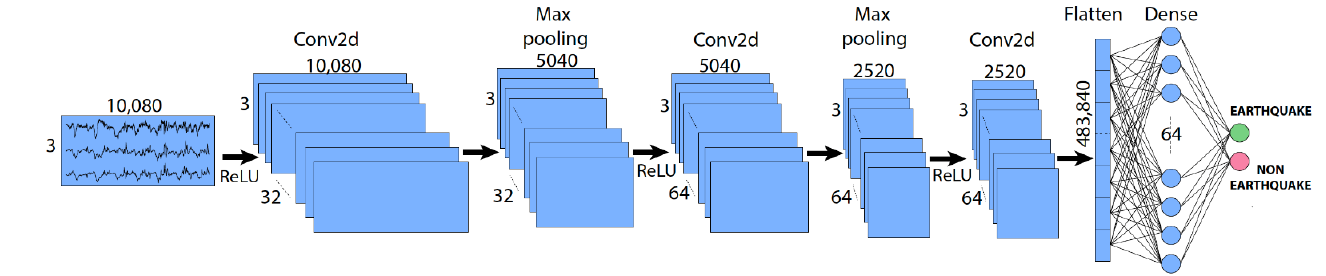
Figure 4. Our proposed deep learning network implementation for classifying the windowed and labeled three-component magnetic field data as precursory to earthquakes or not. This example is for the unfiltered, one-week-long geomagnetic input data.